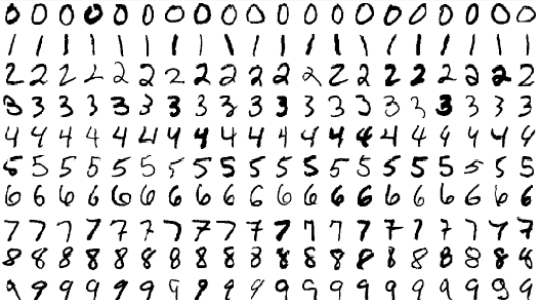
Figure 2. Handwritten digit recognition in MNIST (Modified National Institute of Standards and Technology) database.